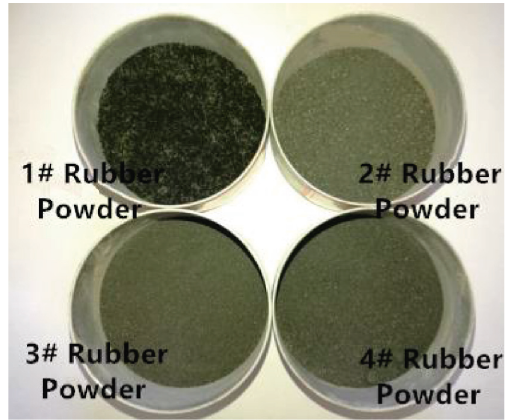
Figure 1: Experimental rubber Table 1: Composition of rubber powder particles. Meshes Size of sieve hole (mm)